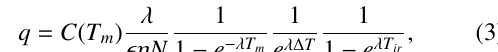
Table 2. Comparison of 235 U SACS measured in this work with data calculated using CIELO-g6 PFNS and IRDFF-1.05 cross sections.